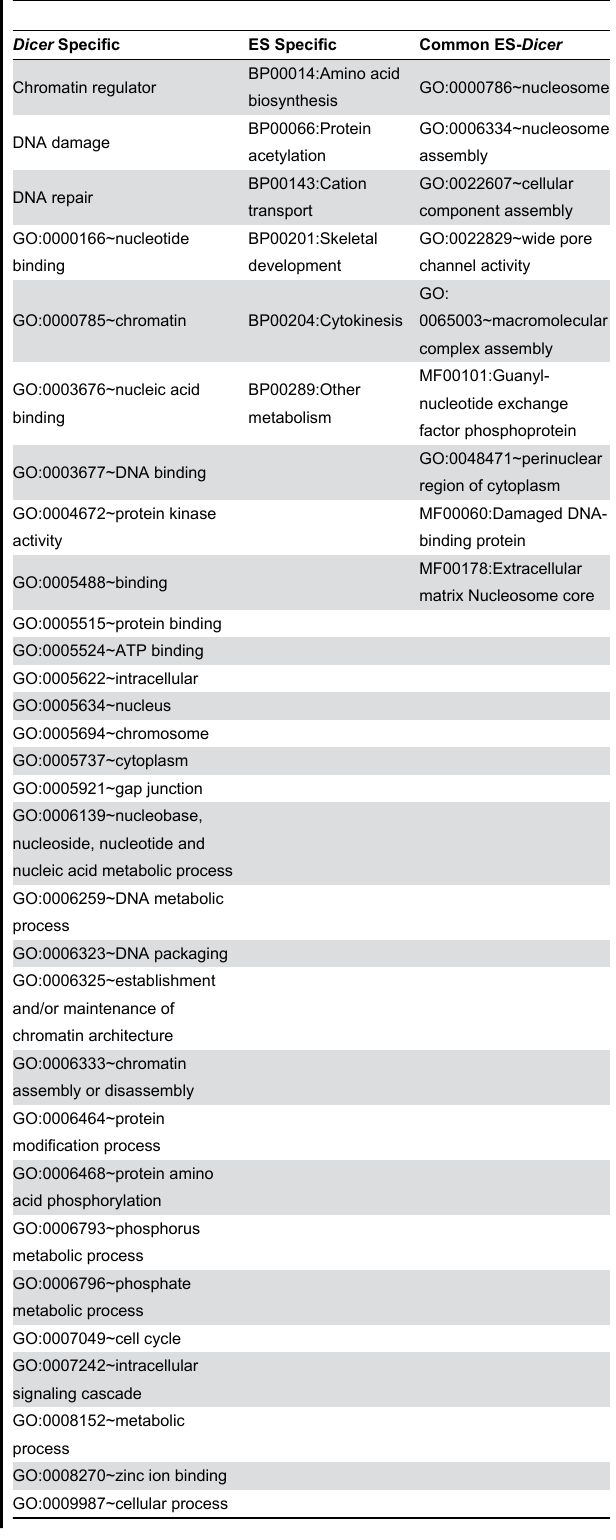
Table 1. Gene ontology terms of differentially methylated CpG island H3K9me2